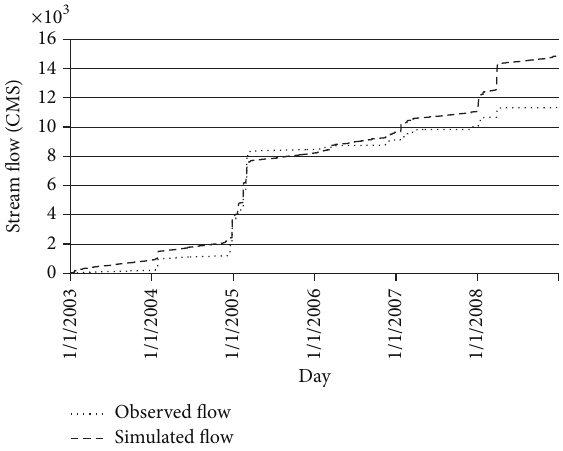
Figure 7: Cumulative daily stream flow m 3 /s (CMS) for validation period.